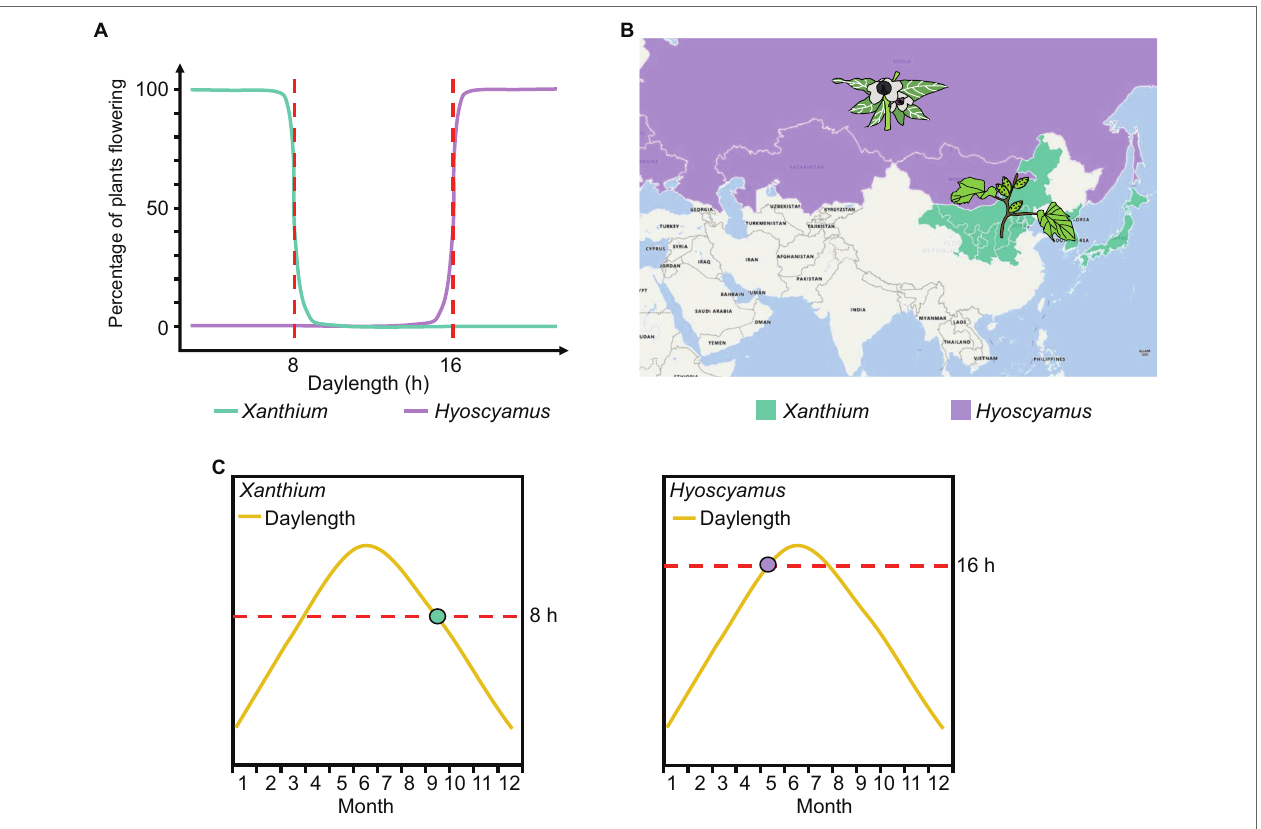
FIGURE 3 | Traditional and new measurement methods of critical daylength. (A) As the flowering ratio of plants under different daylengths. The red dotted line represents the critical daylength. (B) Geographical distribution of Xanthium and Hyoscyamus . (C) Putative expression time point of the florigen genes in Xanthium and Hyoscyamus . The dots represent the point when the florigen begins to be